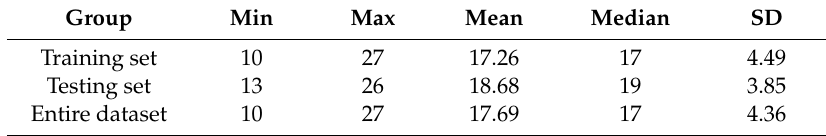
Table 2. Statistical information for the chemical oxygen demand (COD) index for the study area.